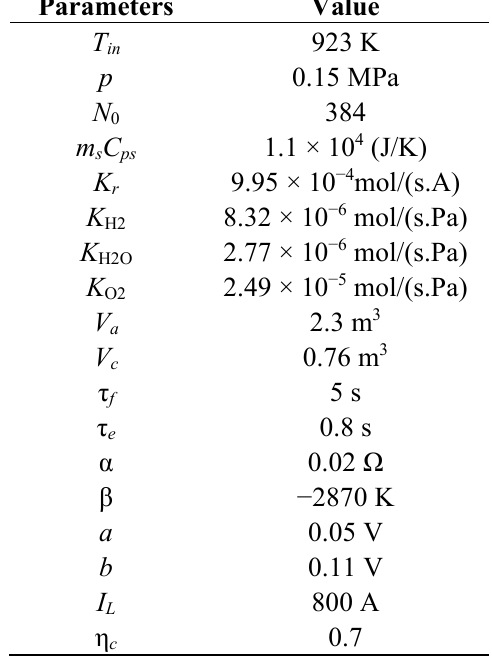
Table 1. Typical 100 kW SOFC power plant data.